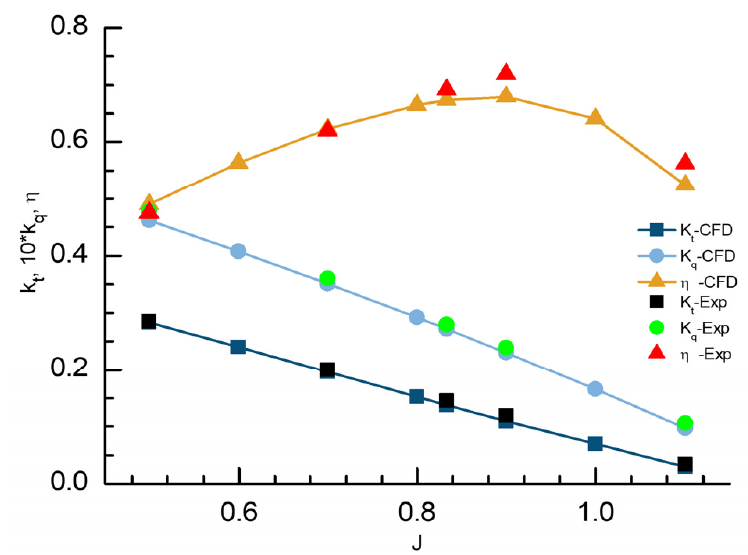
Figure 5. Verification of open water performance of DTMB4119.